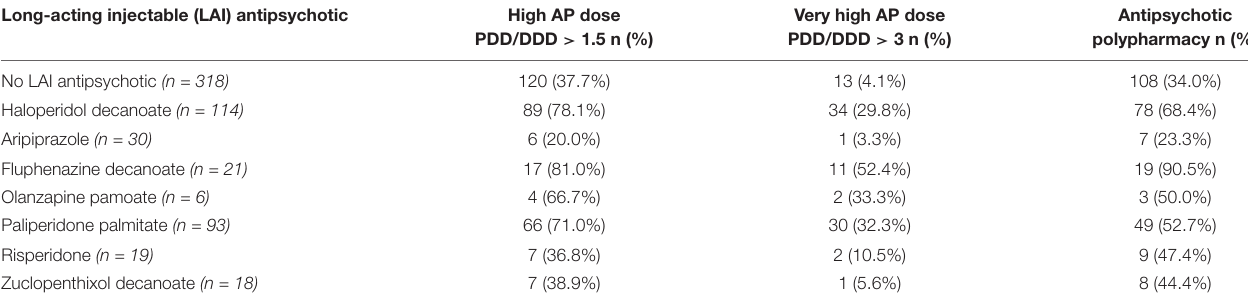
Very high AP dose Antipsychotic PDD/DDD > 1.5 n (%) PDD/DDD > 3 n (%) polypharmacy n (%)